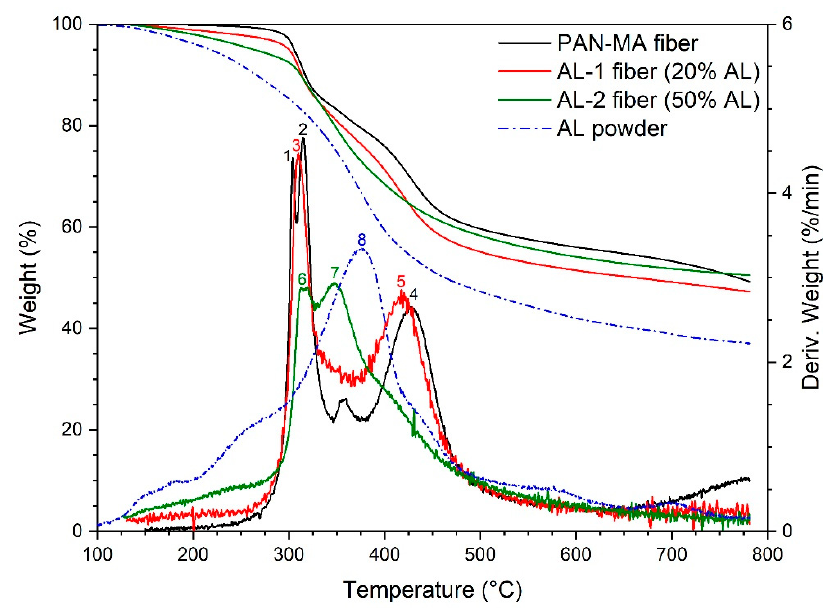
Figure 5. TGA results for powder raw materials (10 °C/min, nitrogen).